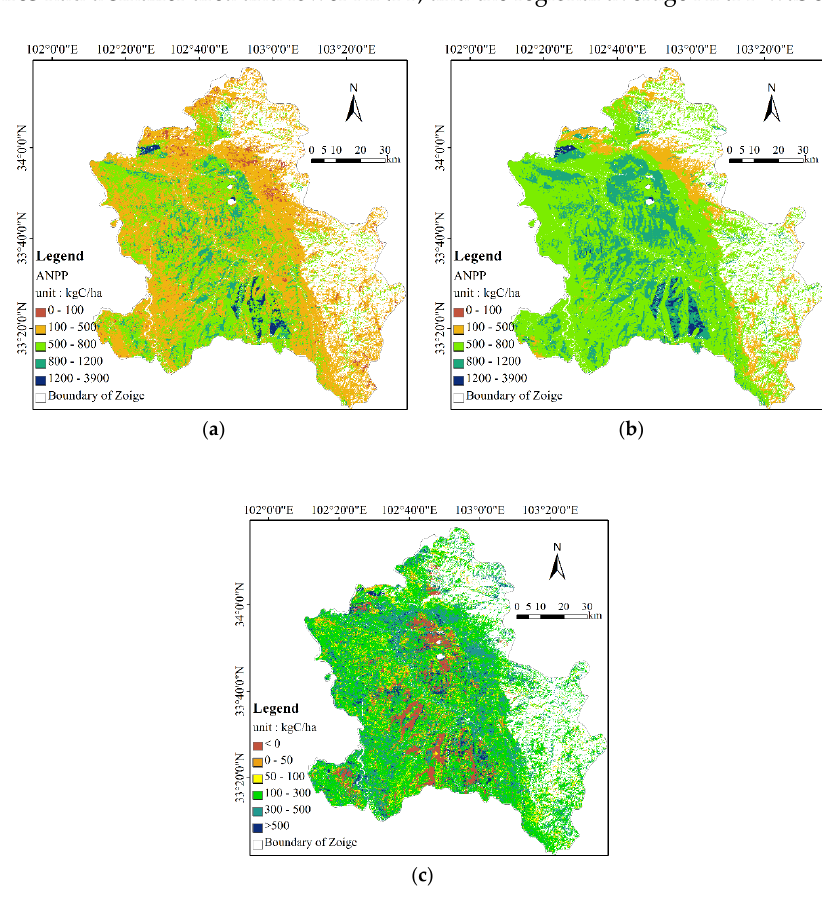
Figure 5. Spatial distribution of the Zoige wetland-grassland ANPP in 2012 ( a ) with considering grazing and ( b ) without considering grazing, and ( c ) the difference between